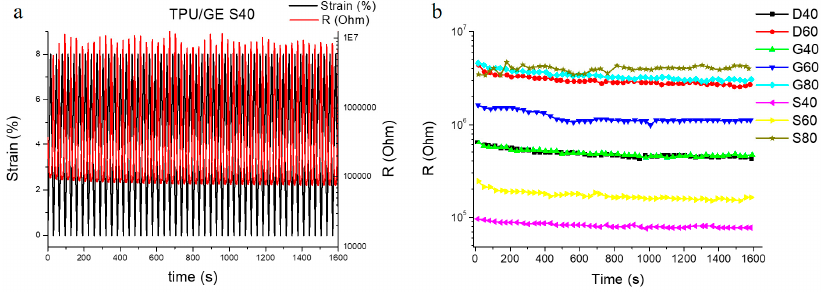
Figure 9. ( a ) Piezoresistive behavior of TPU/GE S40 over 50-cycle compression test, and ( b ) resistance values at 8% strain as a function of time for all TPU/GE composite structures.